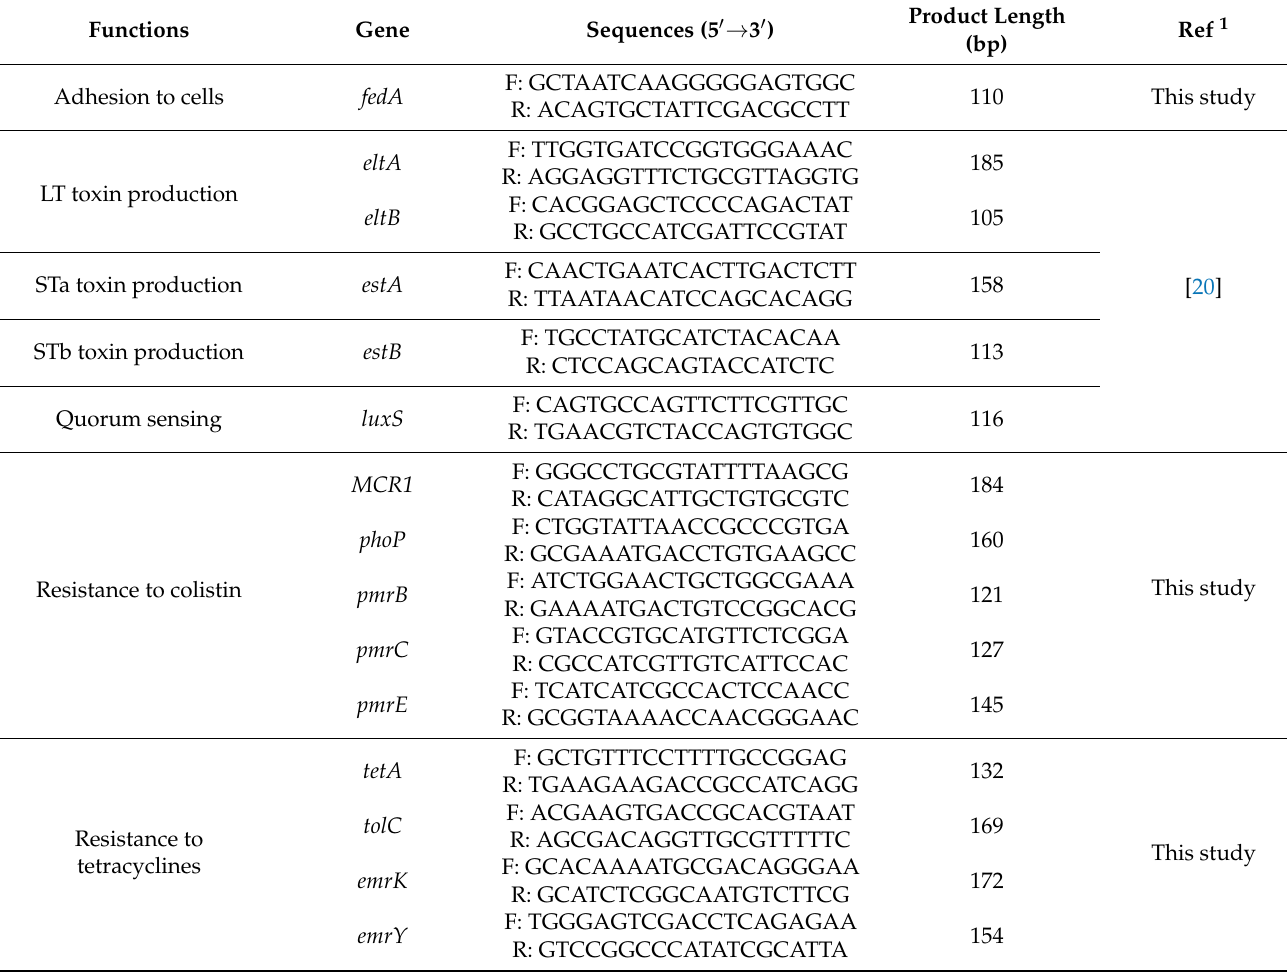
Table 12. Primers used in this study for qPCR